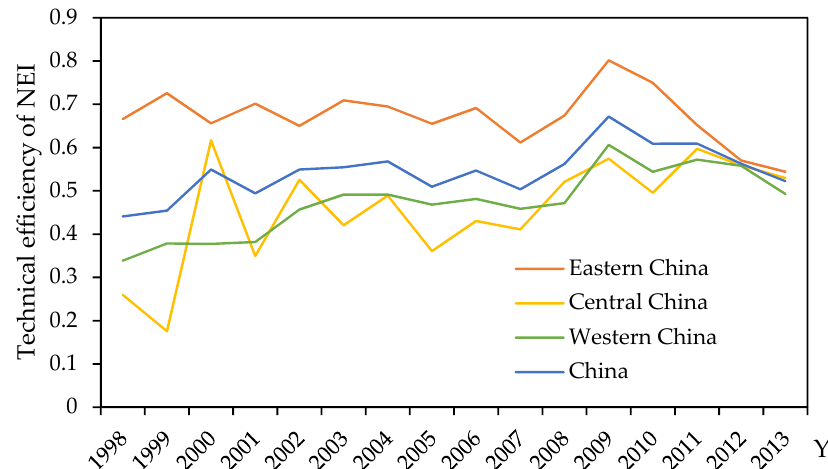
Figure 4. NEI’s technical efficiency in China from 1998 to 2013.